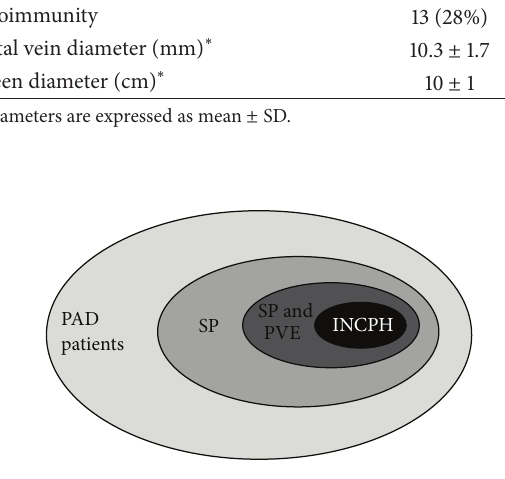
Figure 2: Distribution of PAD patients according to the abdominal ultrasound findings. PAD: primary antibody deficiencies; SP: PAD patients with isolated splenomegaly; SP and PVE: PAD patients with splenomegaly and portal vein enlargement; INCPH: PAD patients with idiopathic noncirrhotic portal